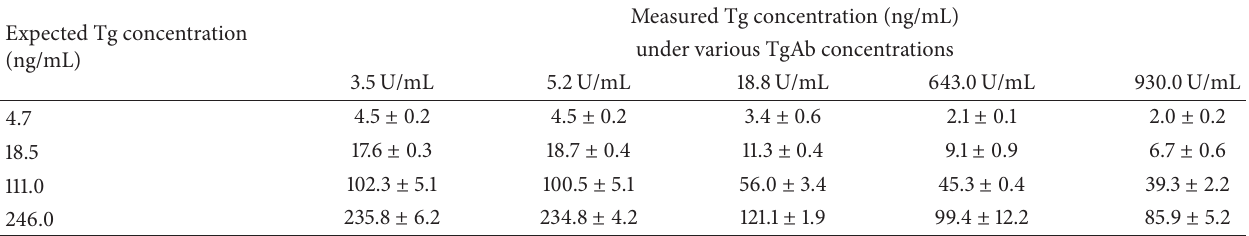
Table 4: Decline of measured Tg value by mixed TgAb in samples produced using patients’ serum.